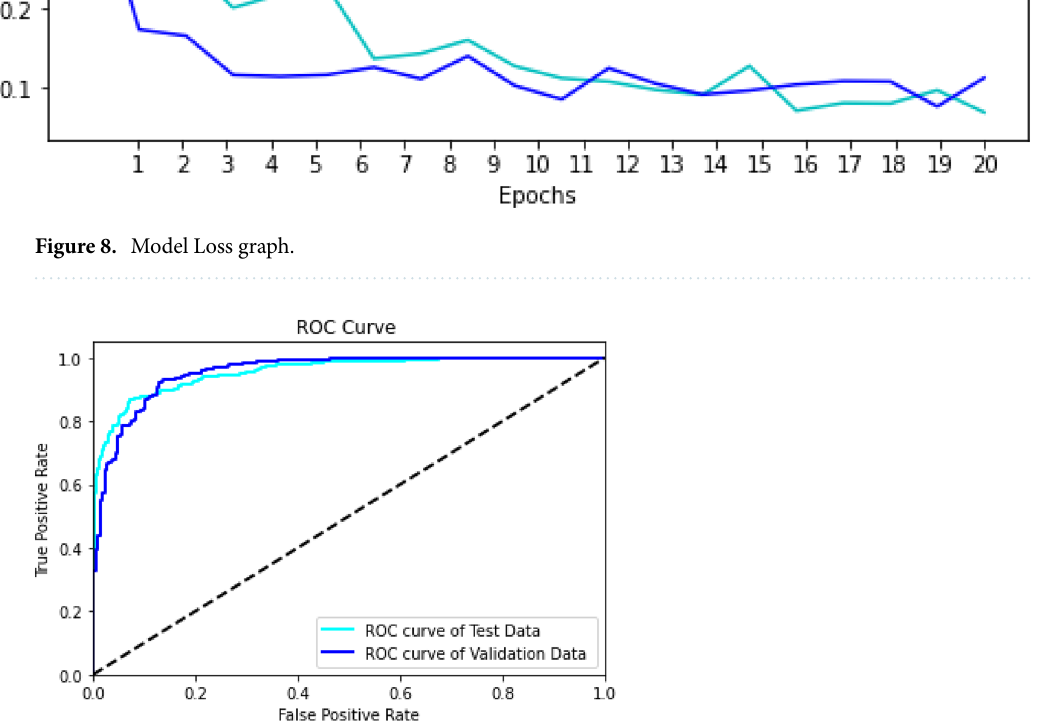
Figure 9. AUC-ROC curve obtained using augmented